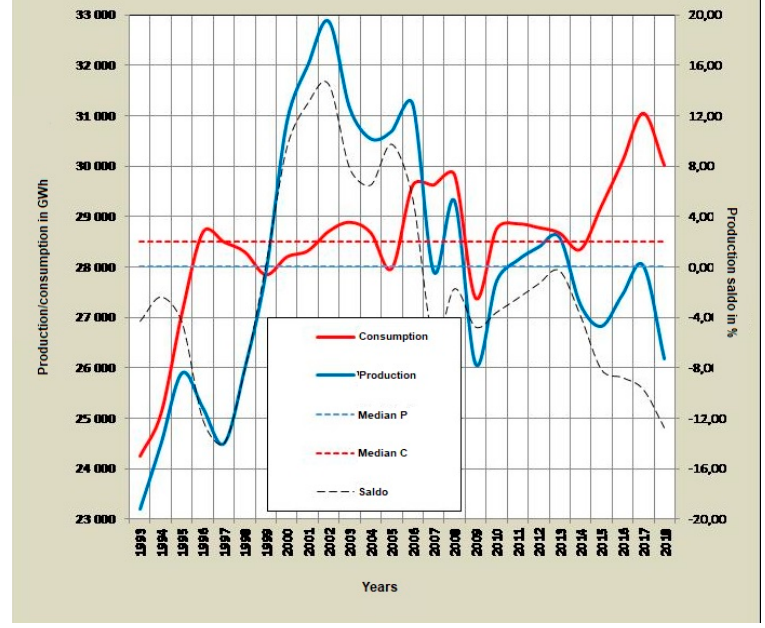
Figure 2. Production and consumption of electricity in Slovakia (Source: [31,32]).